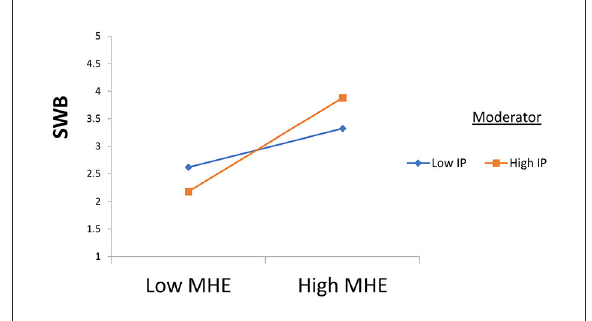
FIGURE4 Moderation 1. MHE, Mental Health Education; IP, Ideological Passion; SWB, College Student’s Wellbeing; PMIA, Politically Motivated Internet Addiction.